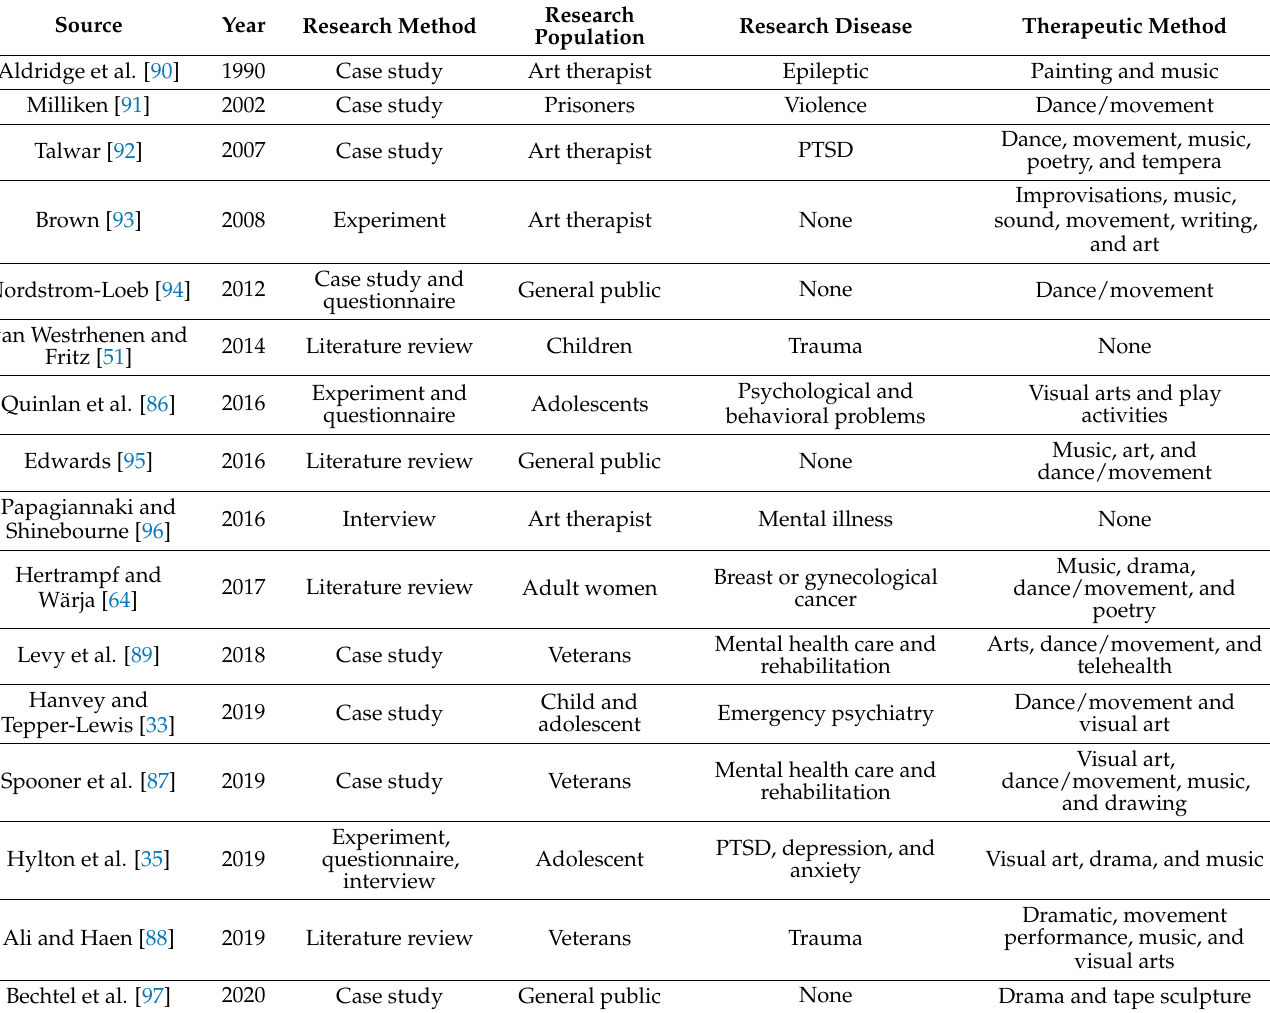
Table 3. The list of creative arts therapy (CAT) studies for health and well-being (devised by the